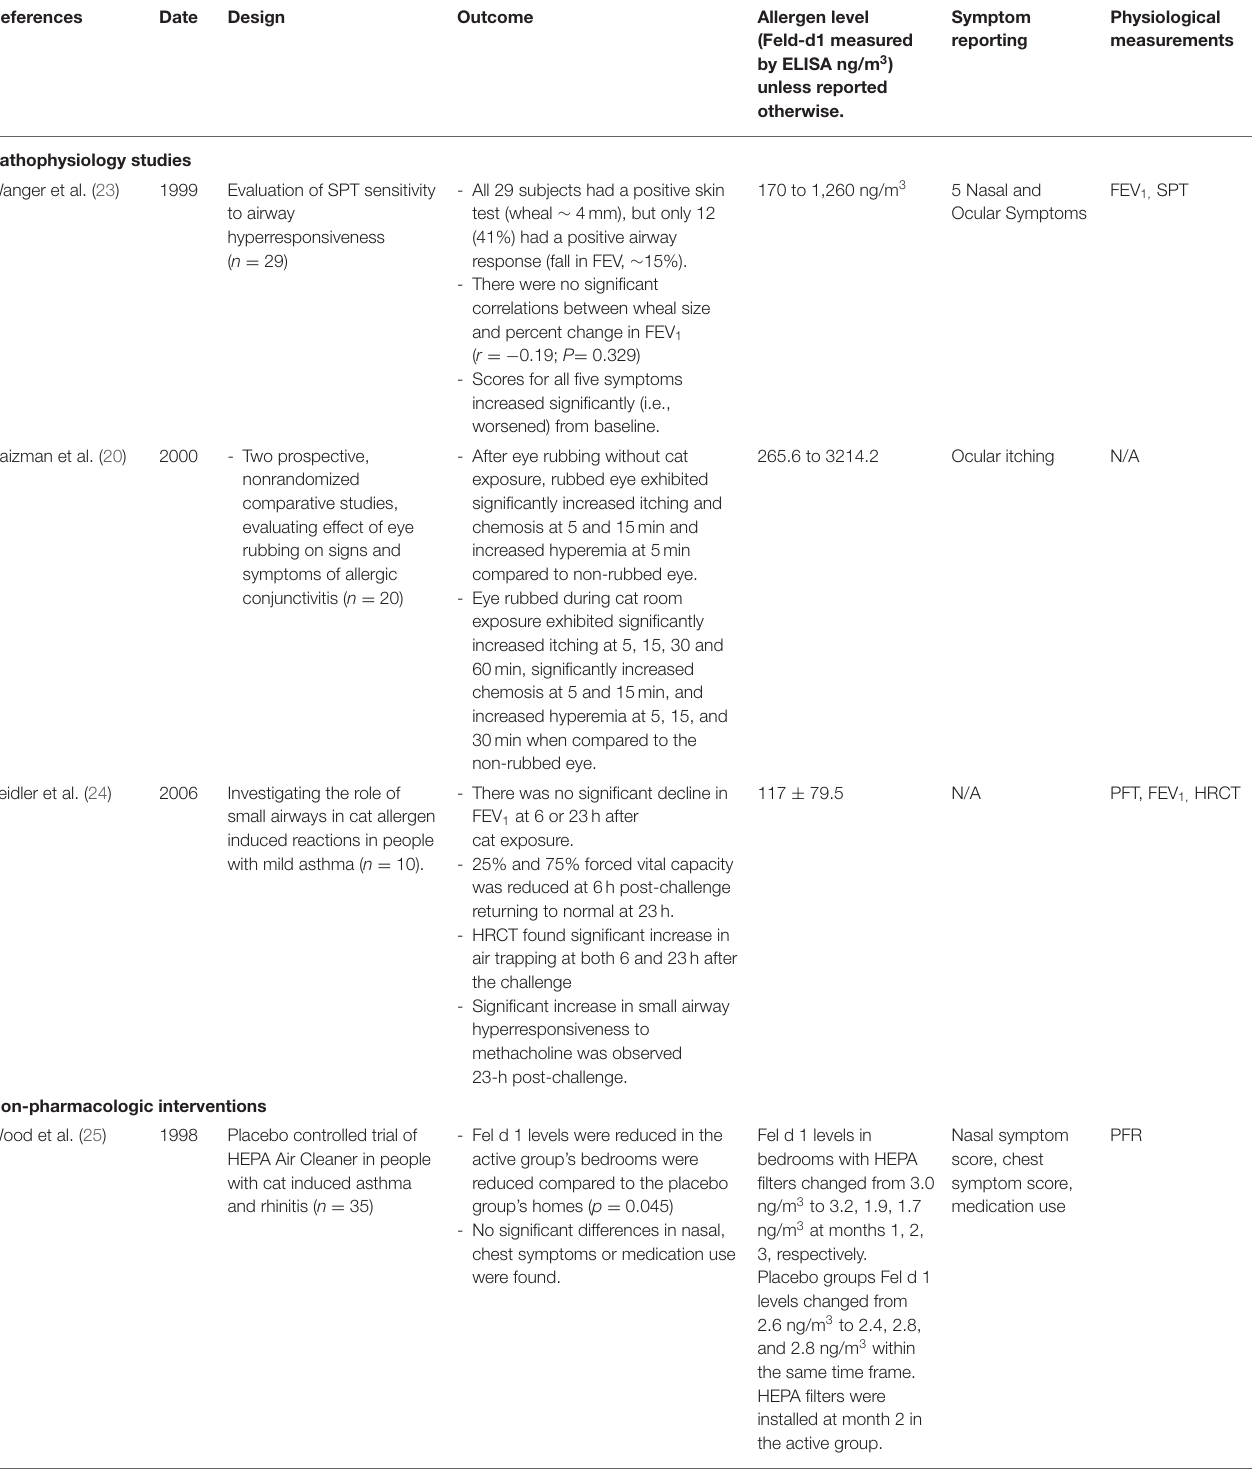
TABLE 1 | Summary of cat room